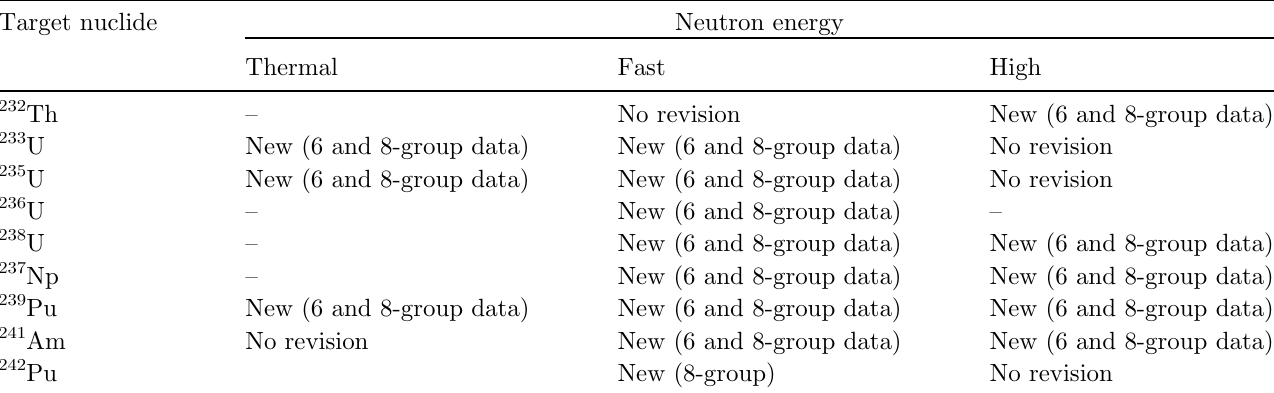
Table 7. The revisions of the DN parameters sets made in the frame of the IAEA/CRP project made on the basis of the experimental IPPE